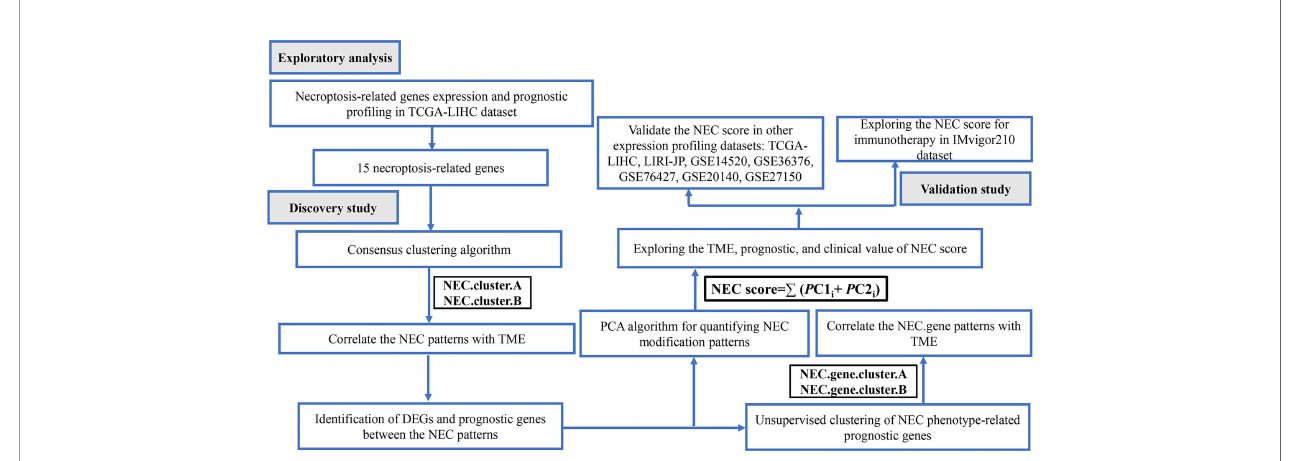
FIGURE 1 | Flow chart of the